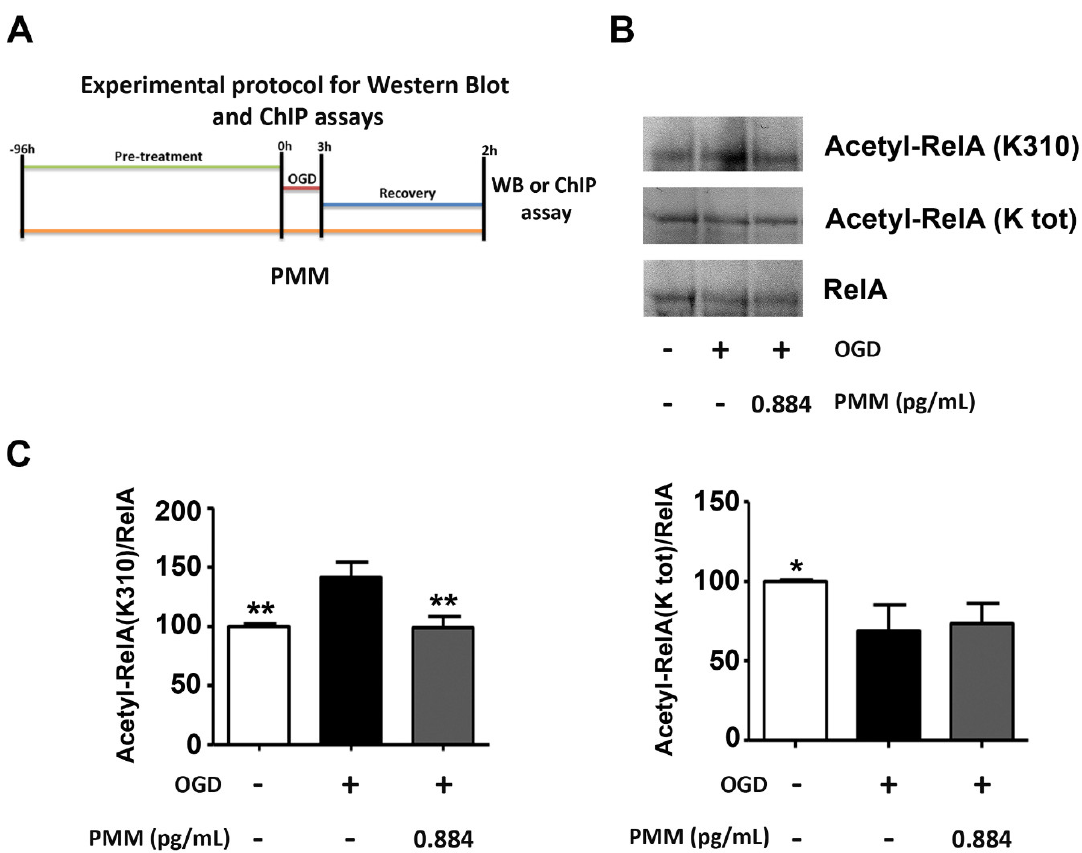
Figure 2. Pre-treatment with PMM reduces ac-RelA(K310) acetylation in cortical neurons exposed to OGD. ( A ) Experimental protocol for the Chromatin immunoprecipitation (ChIP) assay and Western blot (WB) assay in cortical neurons. Cells were pre-treated with the PMM at DIV 7. At DIV 11, cells were exposed to 3 h of OGD and then maintained in recovery medium for 2 h. The mixture was renewed at every change of media. ChIP assays or WB analyses were performed at the end of the 2 h of recovery. The lowest neuroprotective dose of the PMM was added to cells (EGCG 0.10 nM; quercetin 0.11 nM; LA 0.16 nM; resveratrol 0.05 nM; vitamin C 0.89 nM; vitamin E 0.06 nM; vitamin B6 0.02 nM; N-acetyl L-cysteine 0.15 nM). DMSO was used as vehicle in control cells and in neurons exposed to OGD. ( B , C ) Co-IP assay of RelA acetylation in cortical neurons exposed to OGD. The acetylation levels of total lysines (K) of RelA were unchanged after the treatment with the mixture when compared to OGD-treated cells, while the treatment with the PMM restored the normal RelA(K310) acetylation. The bar graphs represent the mean of three different experiments. * p < 0.05 and ** p < 0.01 vs. OGD-treated cells (one-way ANOVA followed by Dunnett’s multiple comparison